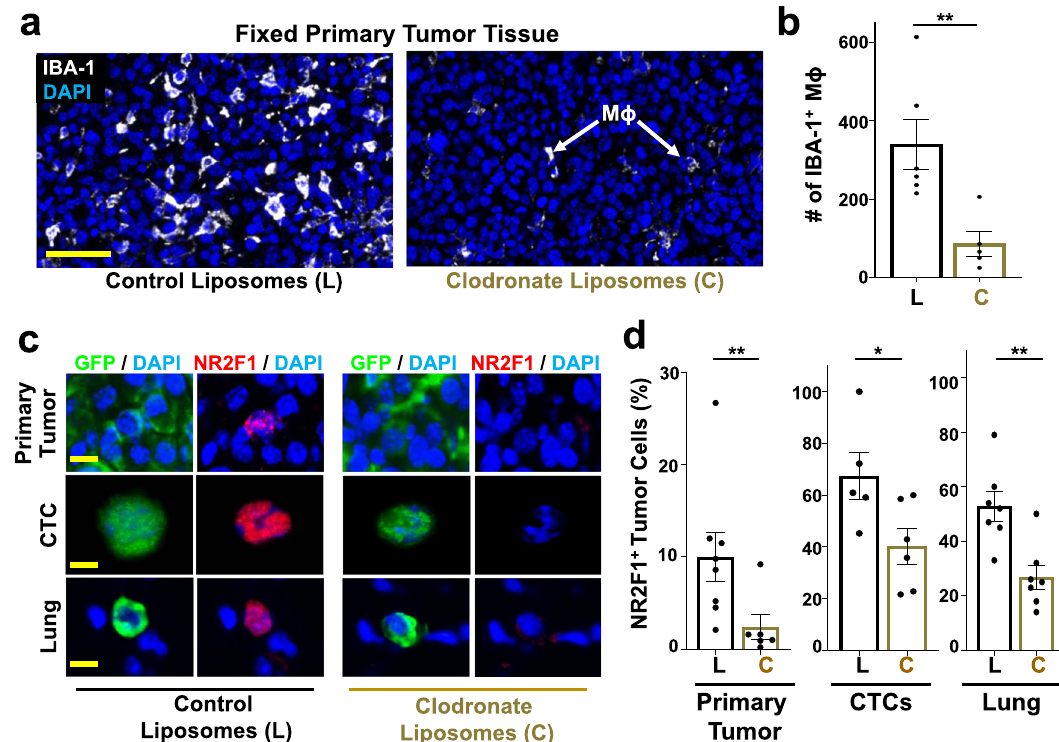
Fig. 8 Macrophage depletion reduces dormancy in primary tumors, CTCs, and disseminating tumor cells in vivo. a Representative immuno fl uorescence images of E0771-GFP primary tumor tissues treated with either control liposomes or clodronate liposomes and stained for macrophages: IBA-1 = White; DAPI = Blue. Scale bar for Primary Tumor = 100 μ m. M ϕ = Macrophage. b Percentage of IBA-1 positive macrophages in 10 fi elds of view (1088 × 629 μ m 2 ) in each group from Fig. 8a. Control Liposomes: n = 60 HPFs in 6 animals. Clodronate liposomes: n = 50 HPFs in 5 animals. Bar = mean. Error bars = ±SEM. Unpaired t-test ( p = 0.0087). ** p < 0.01. c Representative immuno fl uorescence images of NR2F1 expression in primary tumors, circulating tumor cells (CTCs), and disseminated tumor cells (Lung) from an E0771-GFP SM model treated with control (Left) or clodronate liposomes (Right). Green = GFP, Red = NR2F1, Blue = DAPI. Scale bar for Primary Tumor = 50 μ m. Scale bar for CTCs and Lung = 15 μ m. d Percentage of NR2F1-positive tumor cells in each group from Fig. 8c. Control Liposomes - Primary Tumor: 3048 cells in 119 fi elds of view (65 × 65 µ m 2 ) in 8 animals; CTCs: n = 139 cells in 5 animals; Lung: n = 166 cells in 7 animals. Clodronate Liposomes - Primary Tumor: n = 2,298 cells in 79 fi elds of view (65 × 65 µ m 2 ) in 6 animals, CTCs: n = 293 cells in 6 animals; Lung: n = 190 cells in 7 animals. For primary tumor ( p = 0.007), a Mann-Whitney test was used. For CTCs ( p = 0.038) and Lungs ( p = 0.0029), unpaired t-tests were used. * p < 0.05. ** p < 0.01. Source data are provided as a Source Data fi